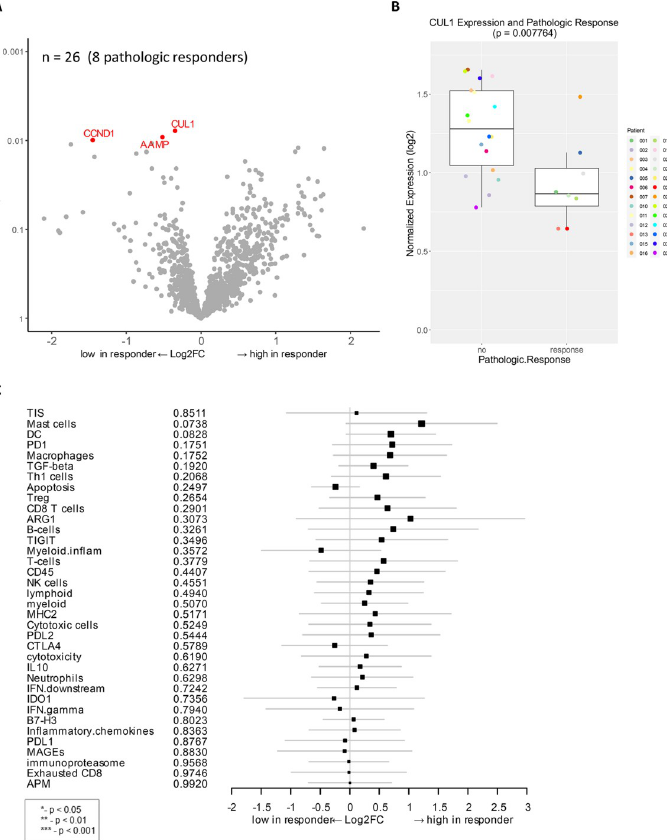
Fig 1. Genes associated with pathologic response to combination immunotherapy of HDI and ipilimumab as a neoadjuvant therapy. A ) Volcano plot of unadjusted p -value vs. log2-fold change of the differential expression in patients who demonstrated pathologic response (unadjusted p < 0.01). Among 27 evaluable patients, 26 available samples (8 pathologic responders) were analyzed. B ) Boxplot of CUL1 expression and pathologic response. C ) Forest plot of difference of gene signature scores between low expression and high expression in pathologic responders. The position of the squared dots denotes the difference of score, and the size denotes the statistical significance. The horizontal lines are the Wald-type confidence intervals. There was no significant p -value in this analysis.